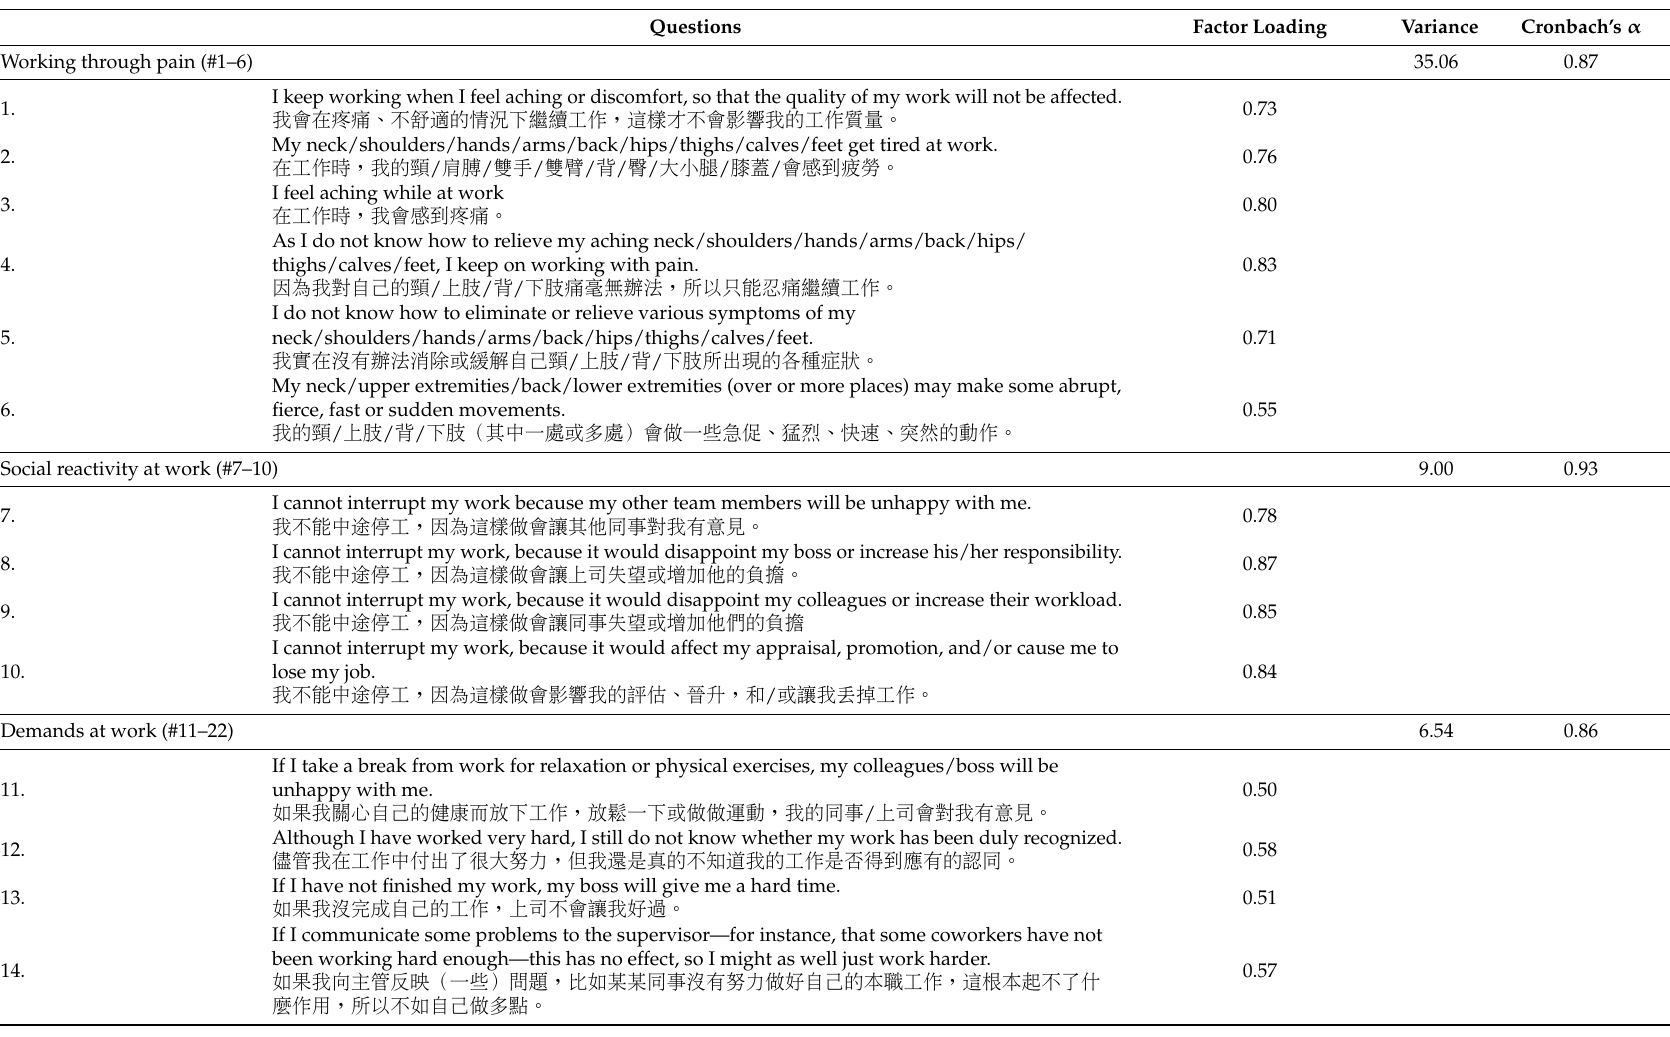
Table 2. Factor structure of the modified C-WSF-24 (workstyle short form) workstyle measure after principal component analysis using varimax